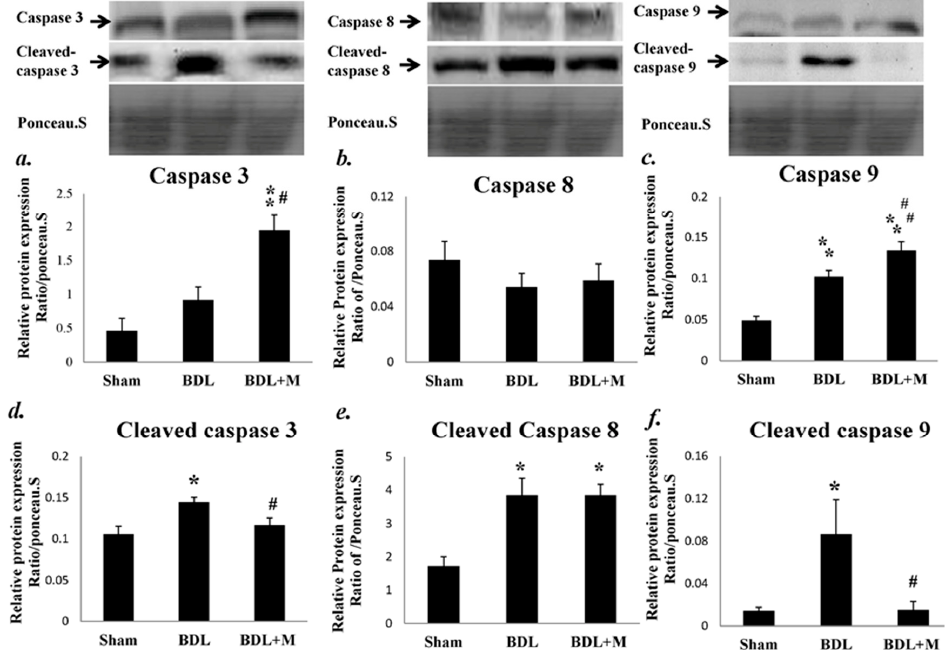
Figure 4. Caspase 3 ( a ) and caspase 8 ( b ) protein expressions were not affected by BDL. BDL for two weeks increased: caspase 9 ( c ); cleaved caspase 3 ( d ); cleaved caspase 8 ( e ); and cleaved caspase 9 protein expression ( f ). Melatonin treatment decreased cleaved caspase 3 and cleaved caspase 9. Significant difference among three groups was analyzed by one-way ANOVA followed by Bonferroni post hoc. All data are shown as mean ± SEM. * p < 0.05 vs. Sham; ** p < 0.01 vs. Sham; # p < 0.05 vs. BDL; ## p < 0.01 vs. BDL.